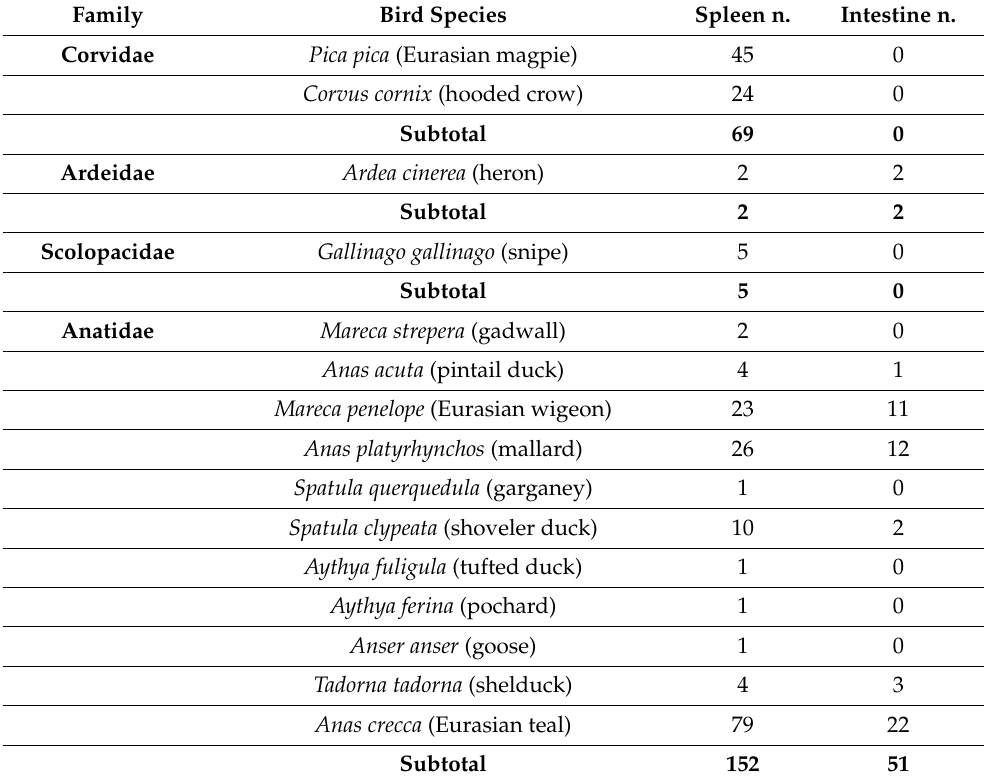
Table 1. Bird species sampled. Family Bird Species Spleen n. Intestine